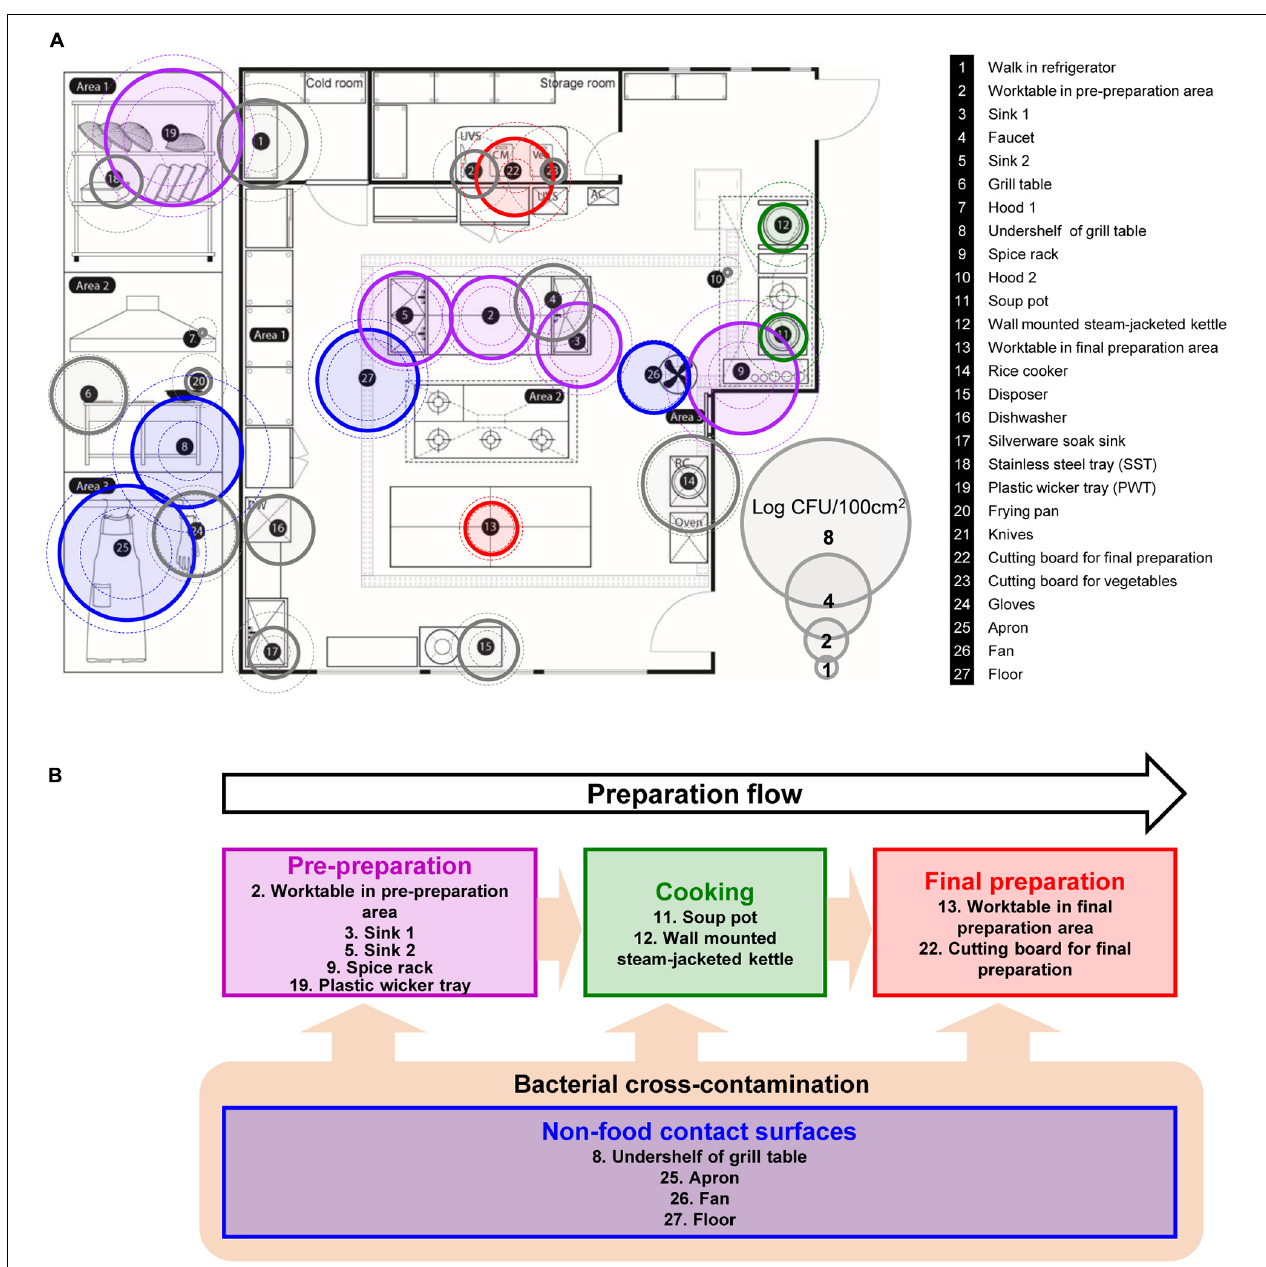
FIGURE 1 | Selected food-contact and non-food contact surfaces, and the preparation flow of the kitchen in a foodservice facility. (A) Total aerobic count (TAC) of twenty-seven surfaces, where each surface is indicated with number with information on the right, (B) schematic diagram of the preparation flow with selected surfaces in the kitchen. The colored circles with solid line are the average TAC of each surface. Outer dotted circles are the maximum counts and inner dotted circles are minimum counts of TAC. Circles that are colored in purple, green, red, and blue indicate each cooking process as pre-preparation area, cooking, final preparation area, and cooking environment, respectively. DW, dishwasher; UVS, UV sterilizer; Veg, vegetable cutting board; AC, air conditioner; RC, rice